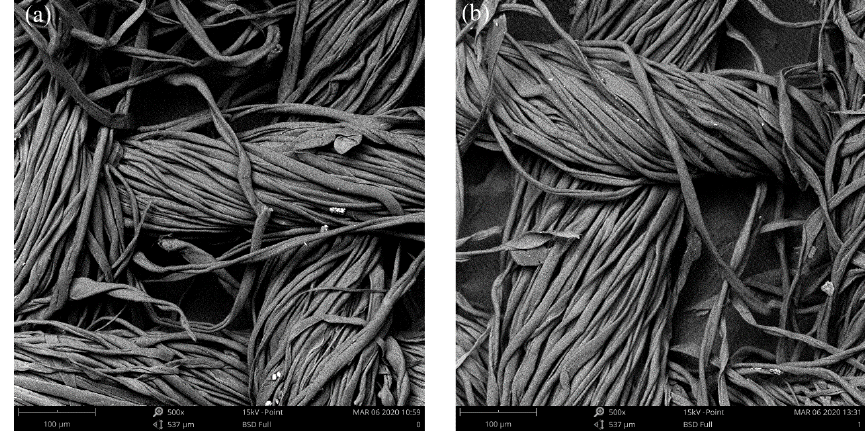
Fig. 5 Surface morphology of cotton fabric (a) before and (b) after tribotesting.